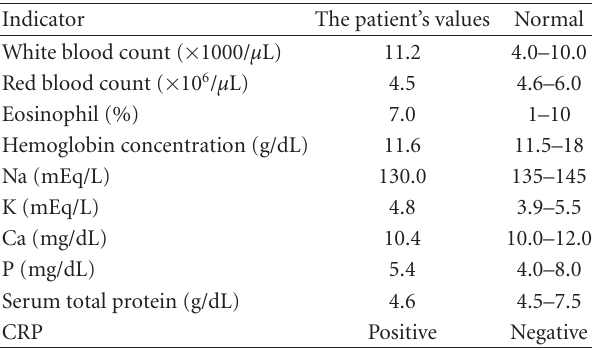
Table 1: The patient’s laboratory test results.